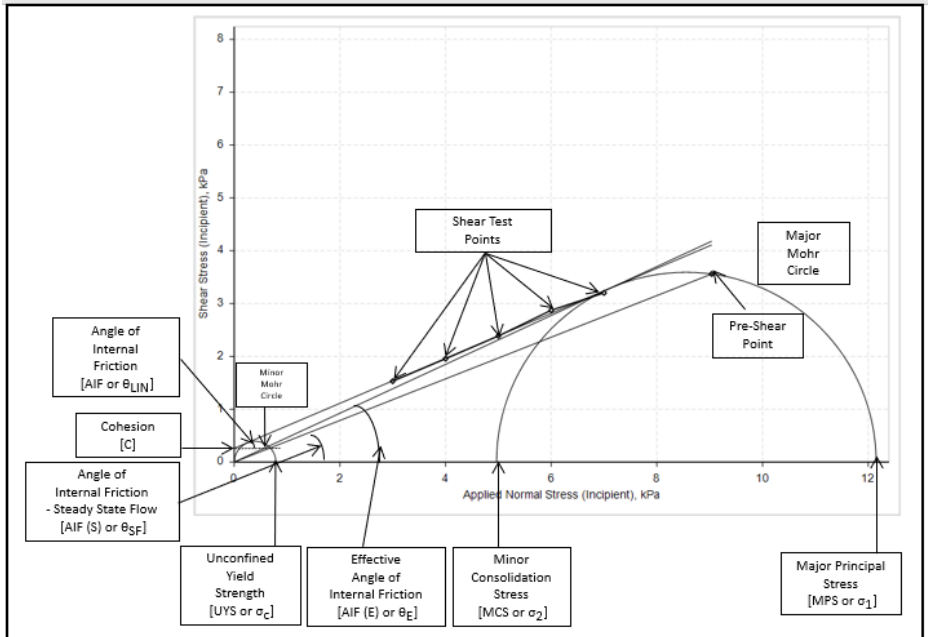
Figure 11. Shear test and yield locus